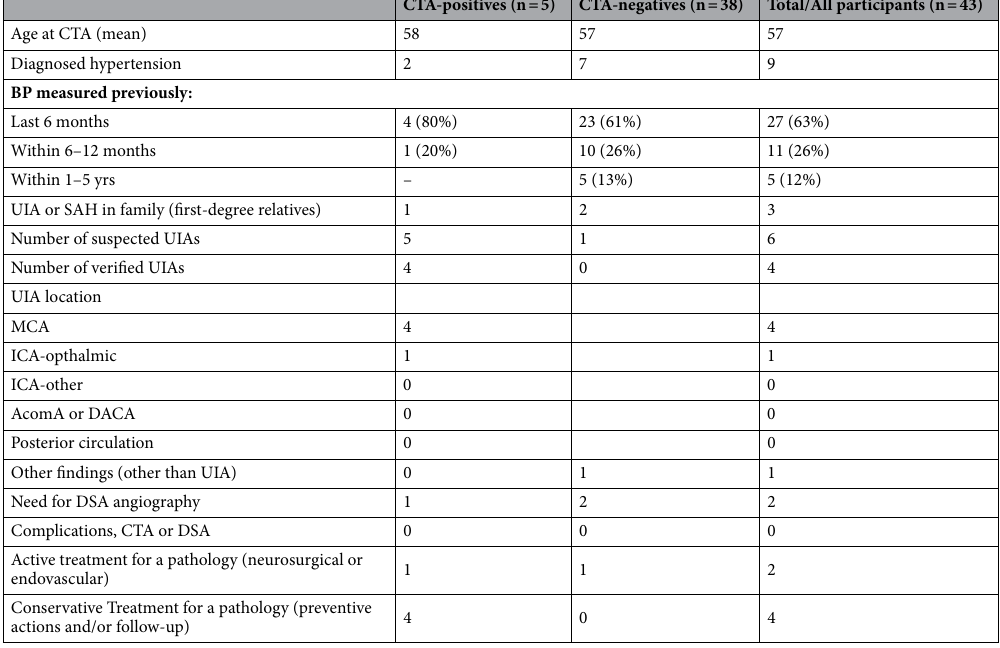
Table 1. Screening results of 43 participants. CTA Computed Tomography Angiography, UIA Unruptured Intracranial Aneurysm, MCA Middle Cerebral Artery, ICA Internal Carotid Artery, AcomA Anterior